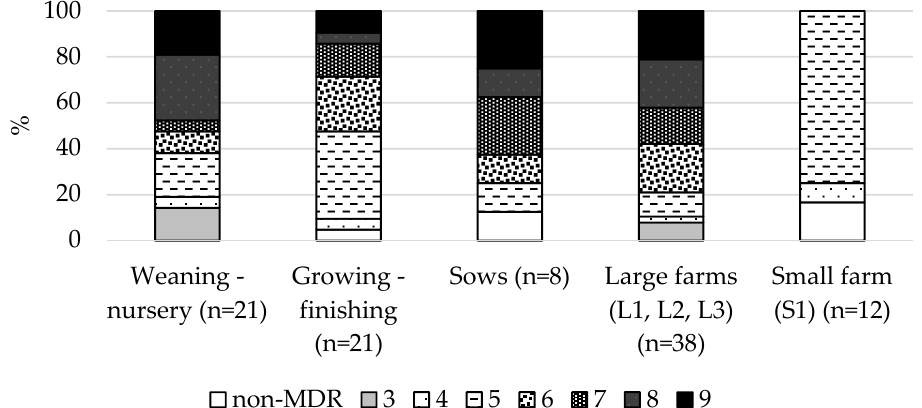
Figure 2. Proportion of different levels of MRD in 50 ESBL-producing E. coli isolates from pigs of different age stages and farms of different sizes.